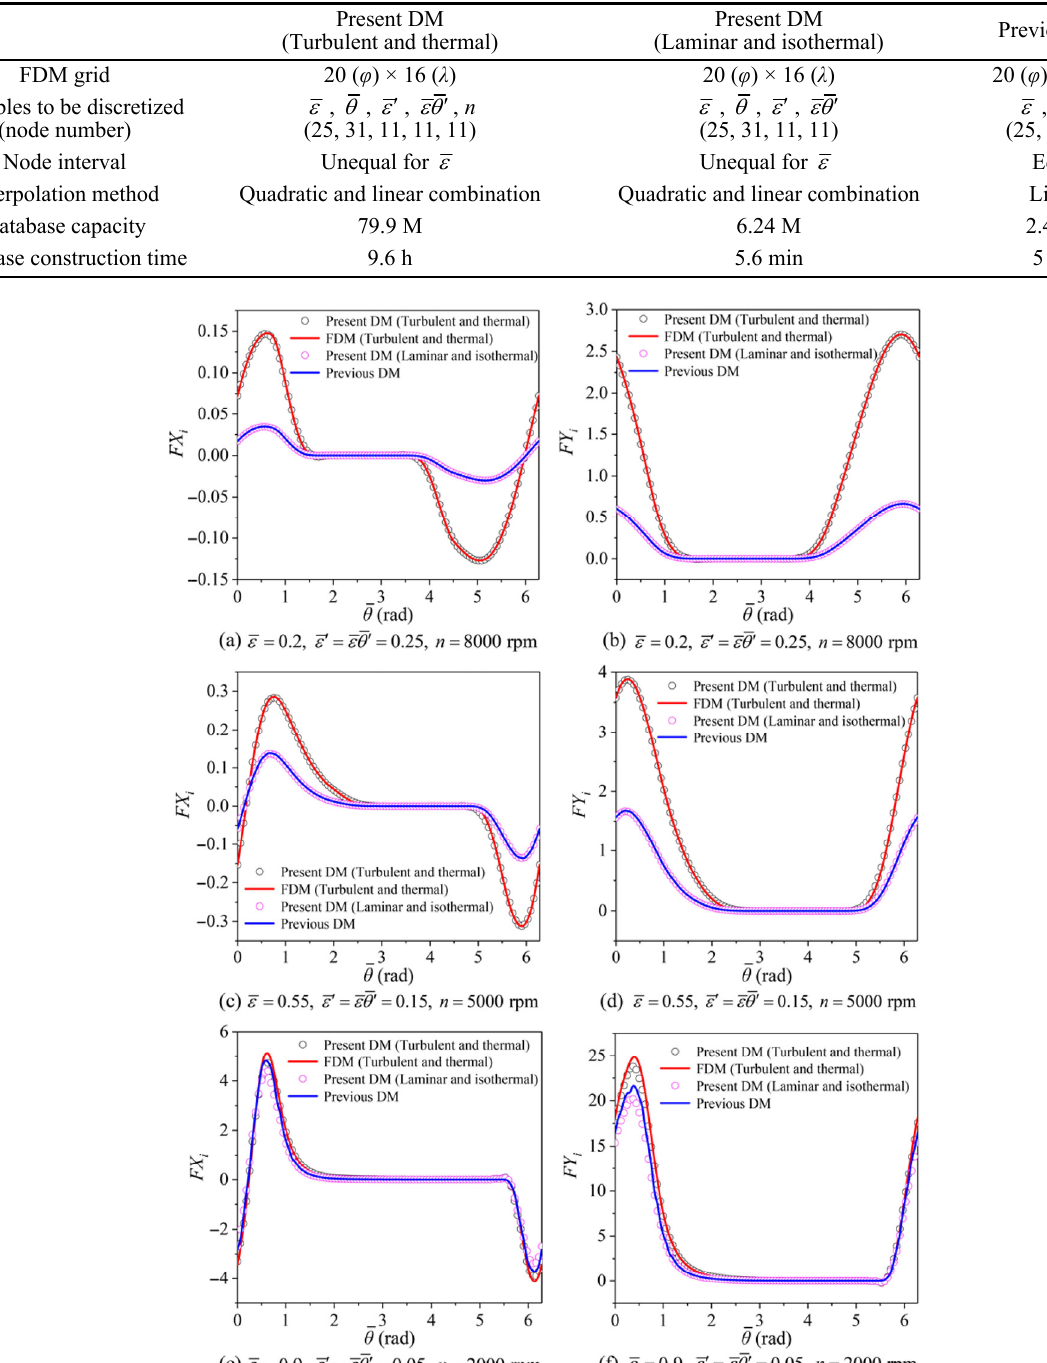
Table 2 Basic comparison of the present DM and the previous DM.